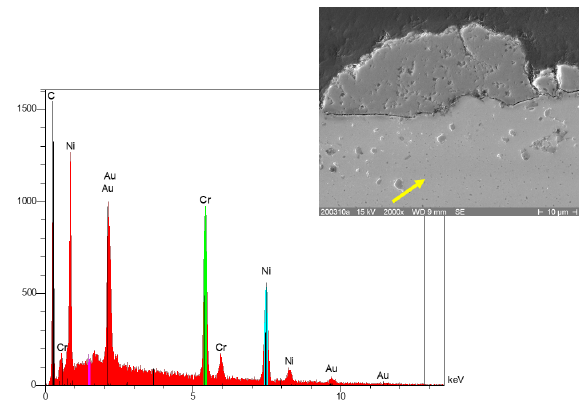
Figure 10. SEM micrograph of the wall beneath the oxide scale of Cr-Ni after oxidation at 1200 °C in steam for 20 hours accompanied with EDS measure- ment of the marked point